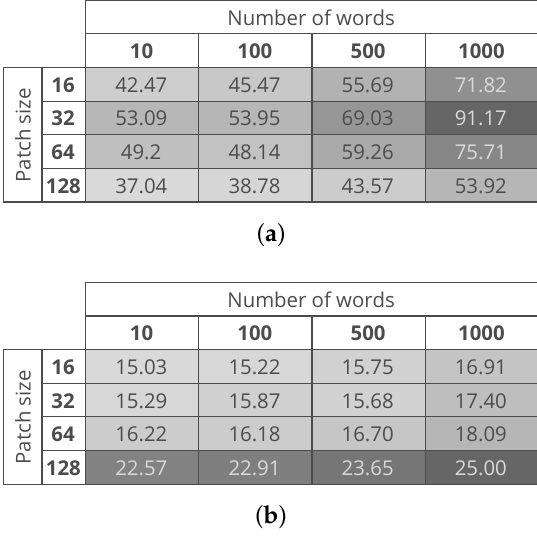
Figure 8. Average time to process a test image. ( a ) time needed in the case of features extracted from the conv5_x of the CNN; ( b ) time needed in the case of features extracted from the avgpool of the